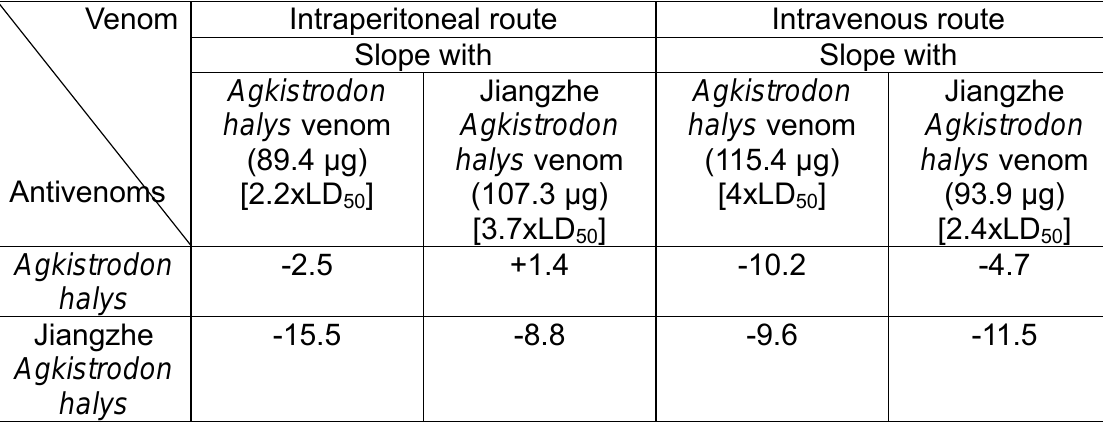
Table 6: Analysis of slopes of Agkistrodon halys and Jiangzhe Agkistrodon halys antivenoms cross-neutralization curves using both intraperitoneal and intravenous injection into mice.